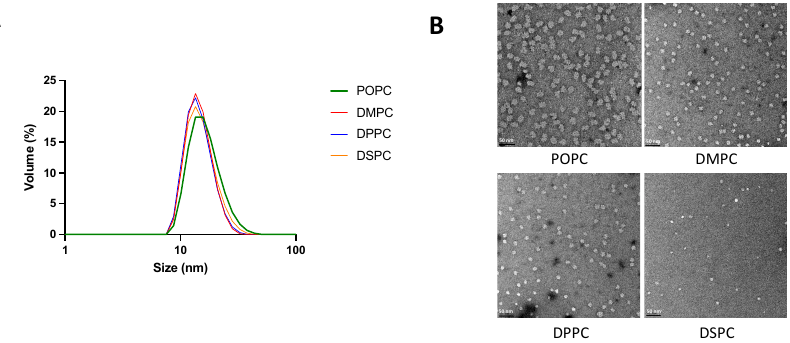
Figure 1. Micelle size and morphology analyzed by DLS ( A ) and TEM ( B ). Malvern Zetasizer Nano ZSP was used to determine the size of micelles diluted with PBS to a 2 mM concentration. Micelles were diluted to 20 μ M in PBS and TEM images were taken on a 100 kV Morgagni TEM equipped with a Gatan Orius CCD.